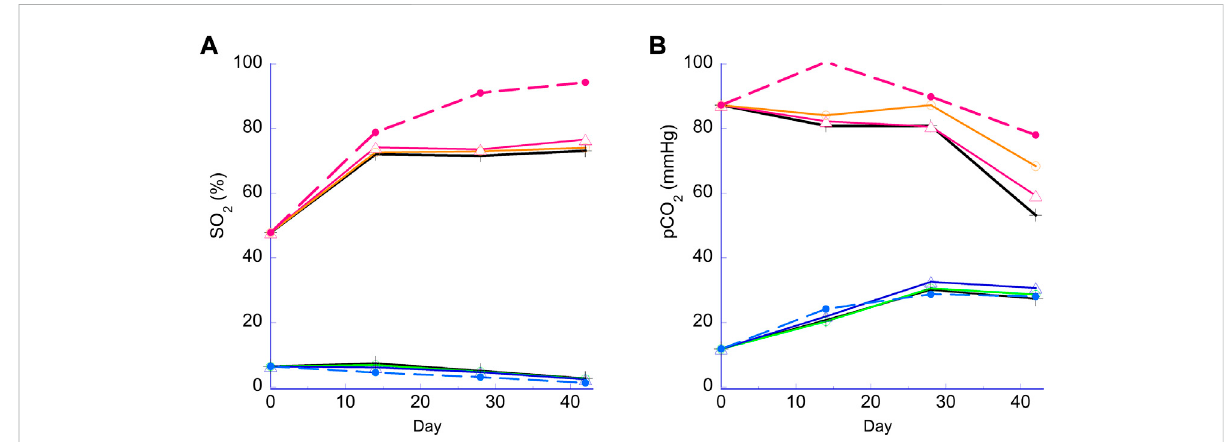
FIGURE 2 Hemoglobin oxygen saturation (sO 2 ) and pCO 2 during storage. Panel (A) sO 2 (%). Panel (B) pCO 2 (mmHg). Lower lines ( < 20% sO 2 or 40mmHg pCO 2 ), H storage; higher lines ( > 40% or > 40mmHg), N storage. Broken lines, PVC bag; open triangle, 2 PVC strips; open circle, 1 PVC strip; cross, no PVC